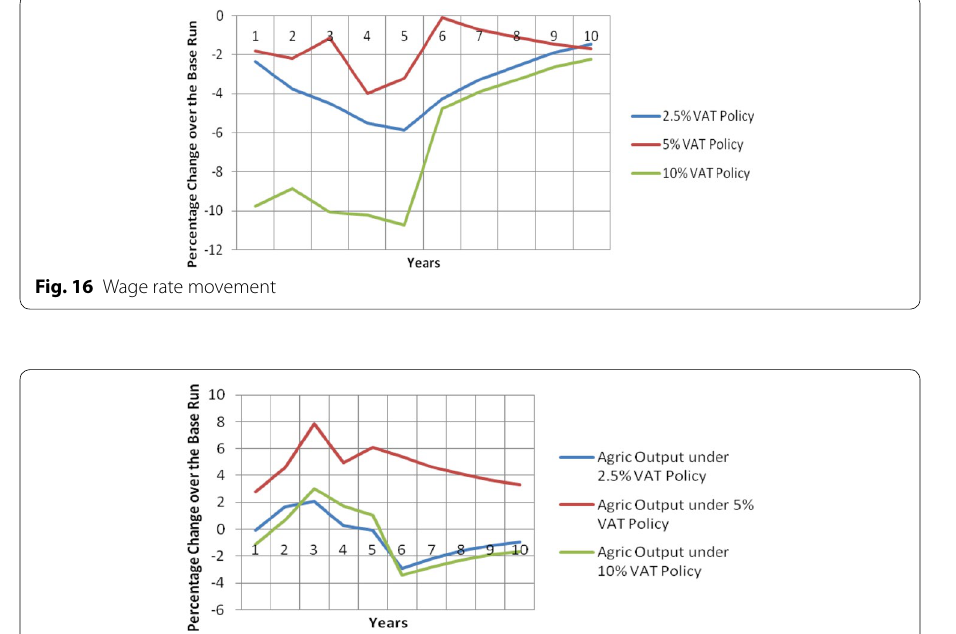
Fig. 17 Impact of different VAT policies on agricultural output